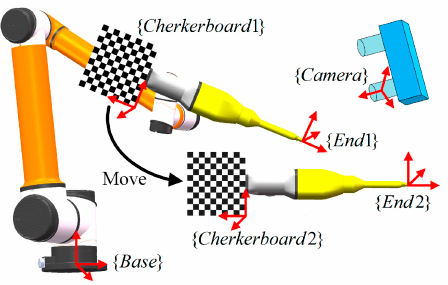
Figure 12. Hand–eye calibration and its coordinate systems.